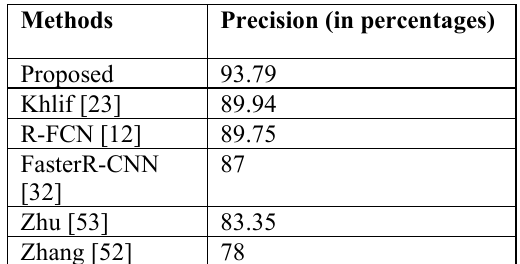
Table 3. Precision of proposed and prevailing methods